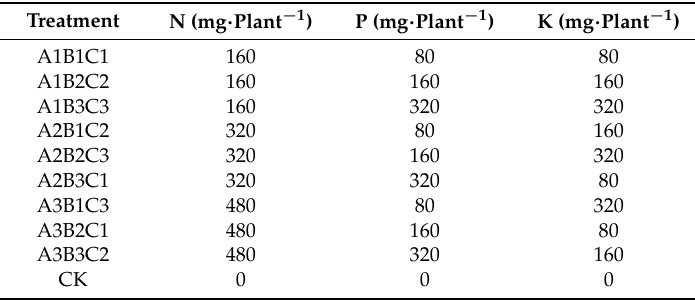
Table 2. Fertilization